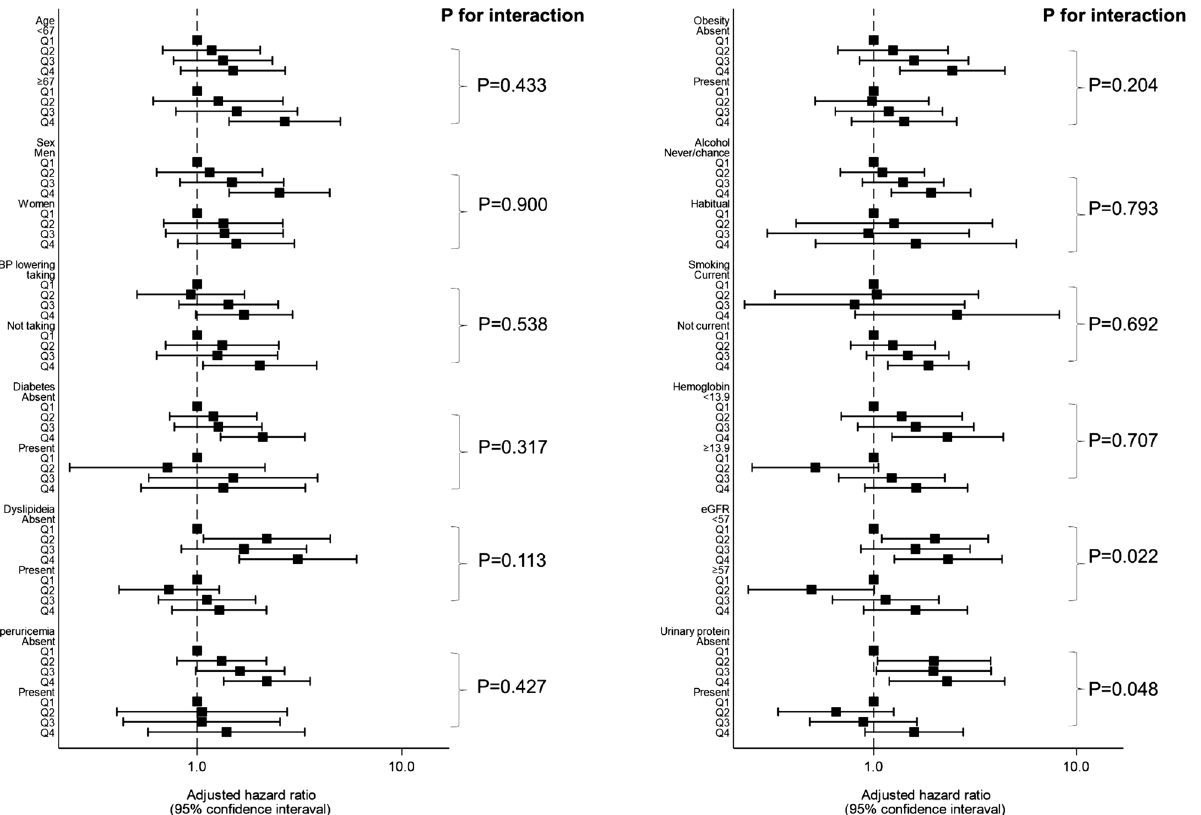
Figure 4. Subgroup analyses: interaction between pulse pressure and each covariate for the progression of CKD. Adjusted hazard ratios and 95% confidence intervals associated with pulse pressure quartile for the progression of CKD were obtained by adding interaction terms to Cox’s proportional hazards models, controlling for sex, age, diabetes mellitus, dyslipidemia, hyperuricemia, obesity, current smoking and drinking alcohol, hemoglobin, and baseline eGFR and proteinuria. P for interaction was obtained by adding interaction terms to the models. Boxes and vertical lines represent hazard ratios and 95% confident intervals, respectively.